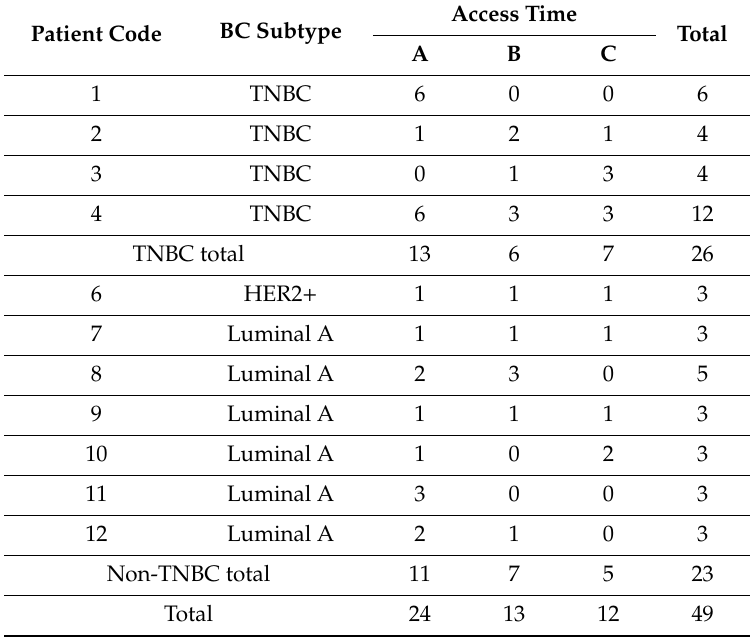
Table 1. Number of CTCs isolated for each patient at each access time A, B and